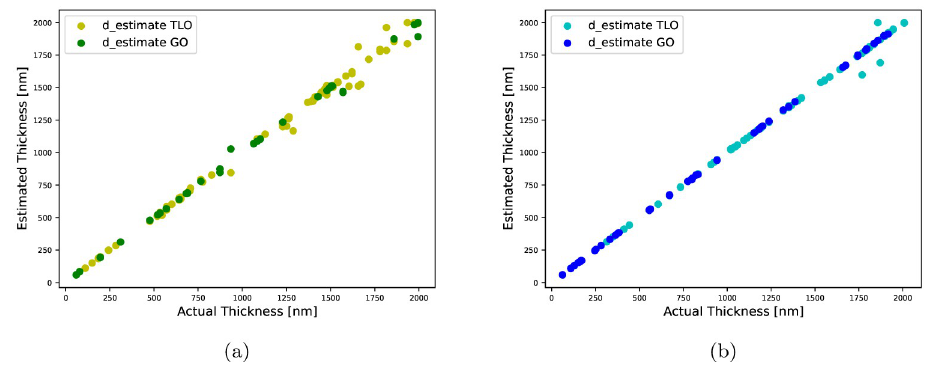
Fig 2. Visual representation of the actual vs. estimated thickness values for the successful occasions reported in Tables 3 and 4: (a) thickness estimates of type A films, (b) thickness estimates of type B films.